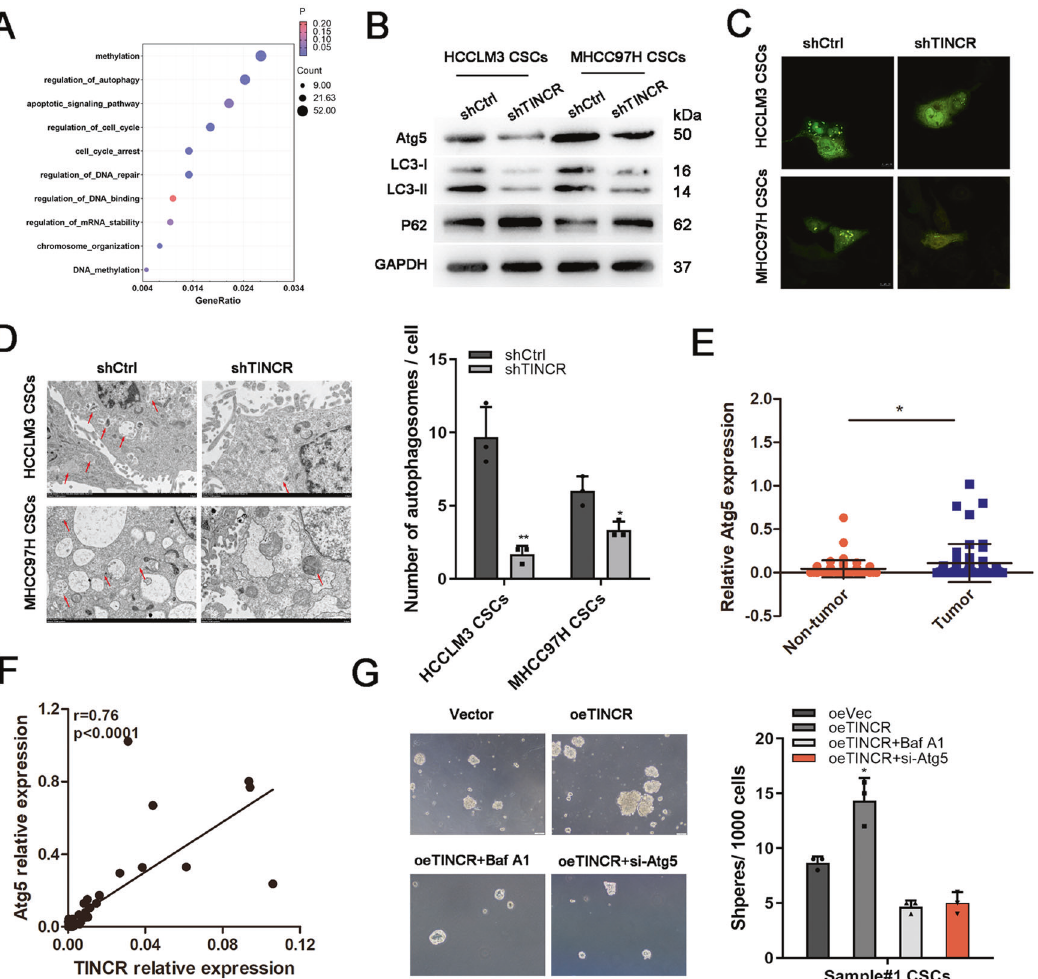
Fig. 4 TINCR regulated ATG5-mediated autophagy. A GO pathway analysis showed the involvement of autophagy in TINCR regulation. B After TINCR depletion, the level of autophagy-related proteins were detected by western blotting. C LC3 fl uorescence intensity was assessed by confocal microscope. Scale bar: 10 μ m. D Representative images of autophagosome detected by TEM. E ATG5 expression in HCC tissues was evaluated by qRT-PCR. F ATG5 expression was positively correlated with TINCR expression ( r = 0.76, p < 0.0001). G When LCSCs